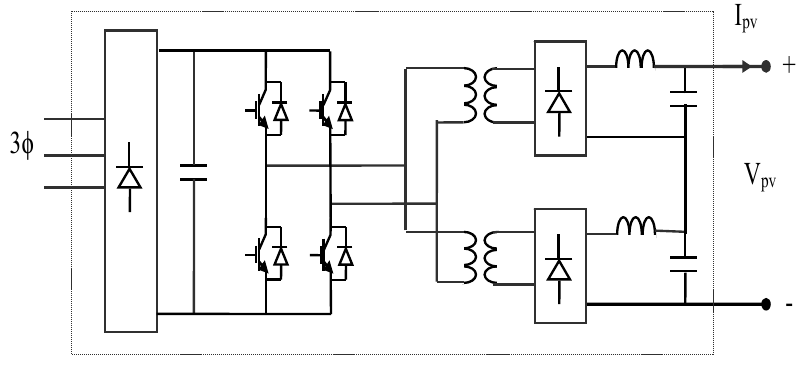
Figure 9. Electrical circuit connection of the high-power PV simulator [18].